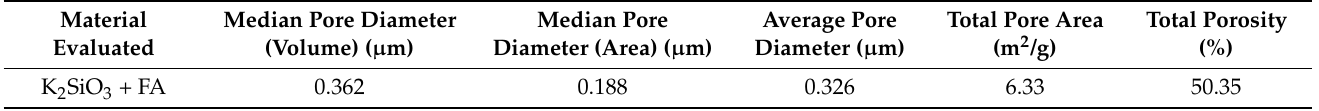
Table 1. Characterization of the obtained porous materials by mercury